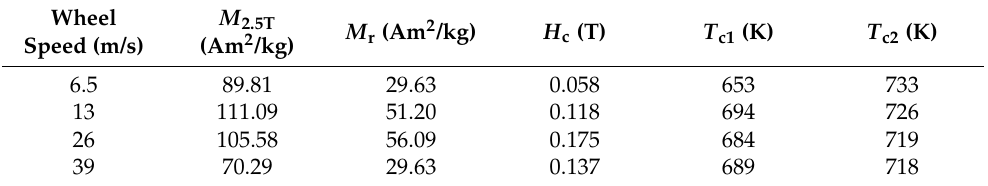
Figure 2. Magnetic hysteresis loops of the Sm(Fe 0.8 Co 0.2 ) 10 Si 2 ribbons with different wheel speeds. Table 2. Magnetization at 2.5 T ( M 2.5T ), remanent magnetization ( M r ), coercivity ( H c ), and Curie tem- perature ( T c ) of the Sm(Fe 0 . 8 Co 0 . 2 ) 10 Si 2 ribbons with different wheel speeds.